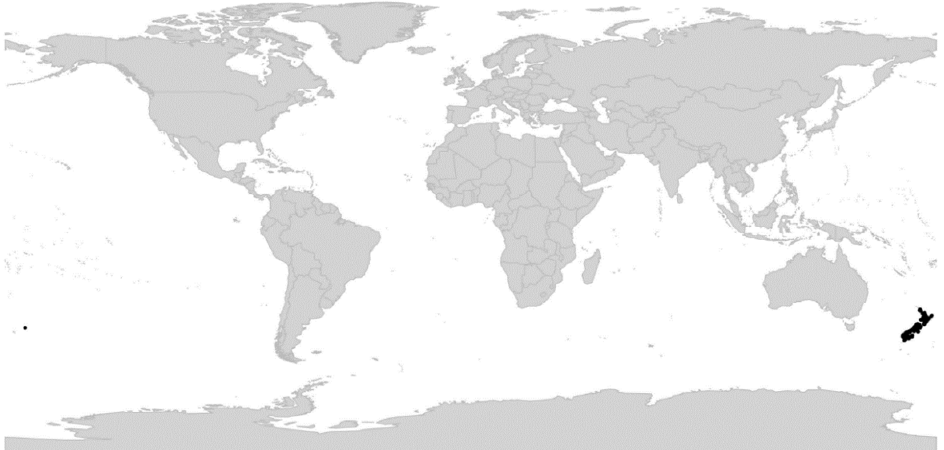
Figure 22. Global distribution of Viola sect. Nematocaulon